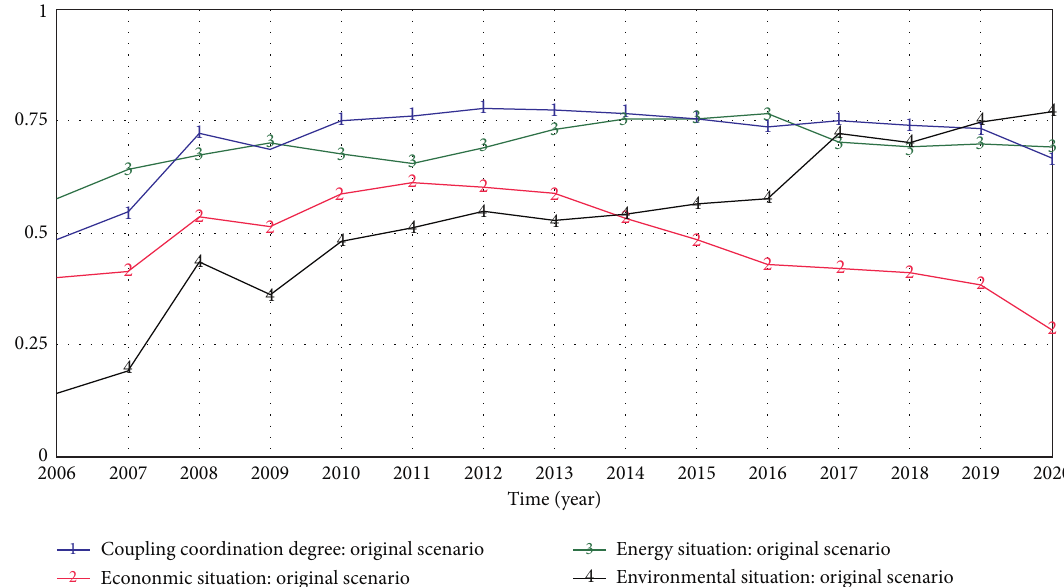
Figure 5: Green low-carbon development of coal enterprises under the original scenario.